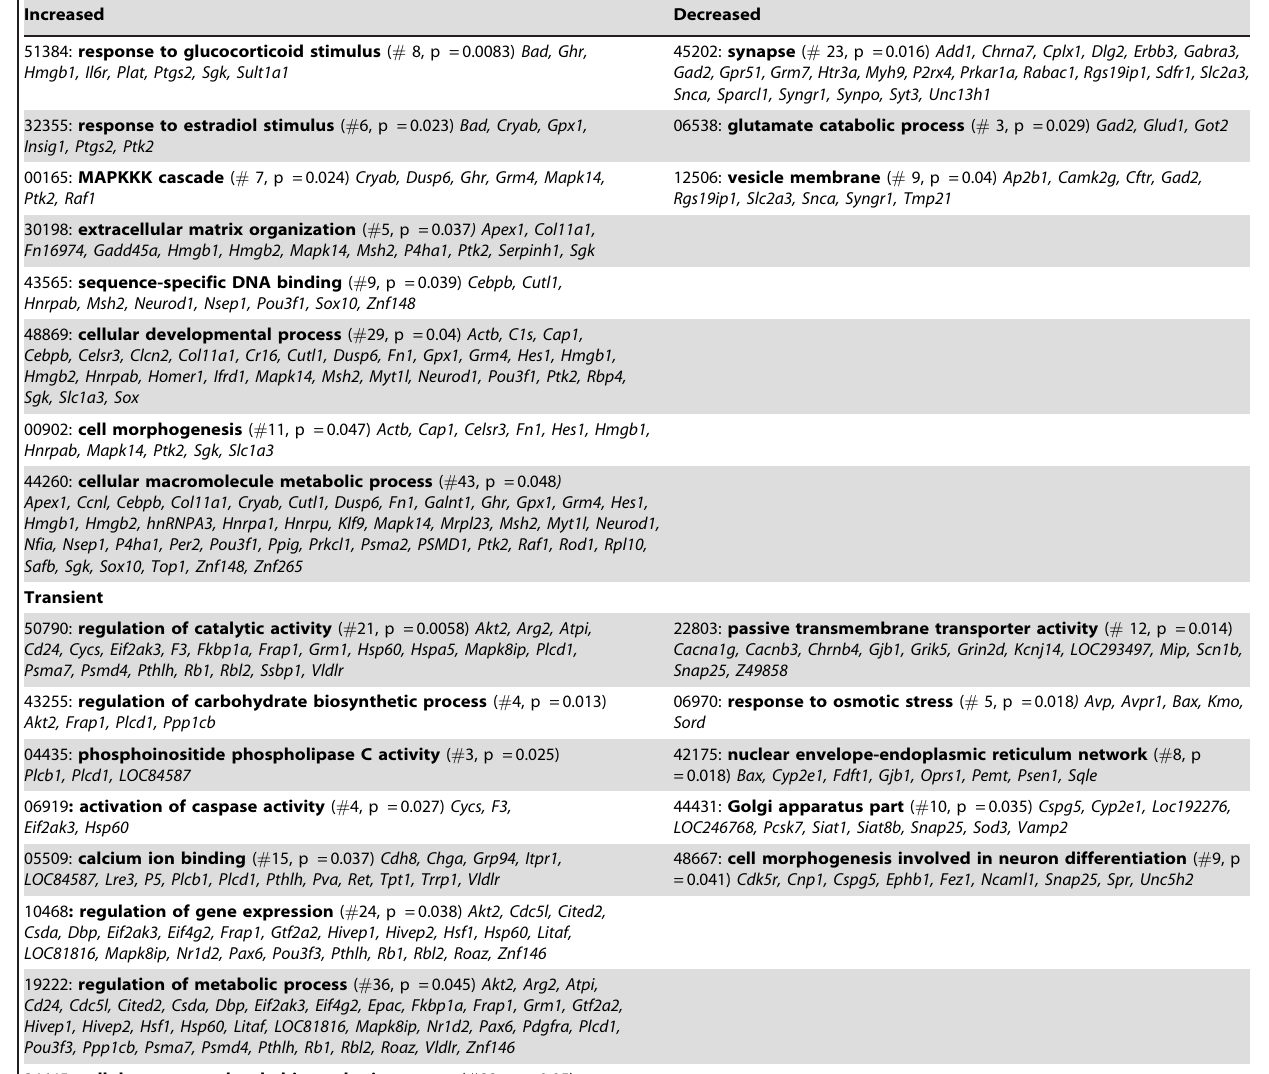
Table 1. Pathways influenced by sleep deprivation.